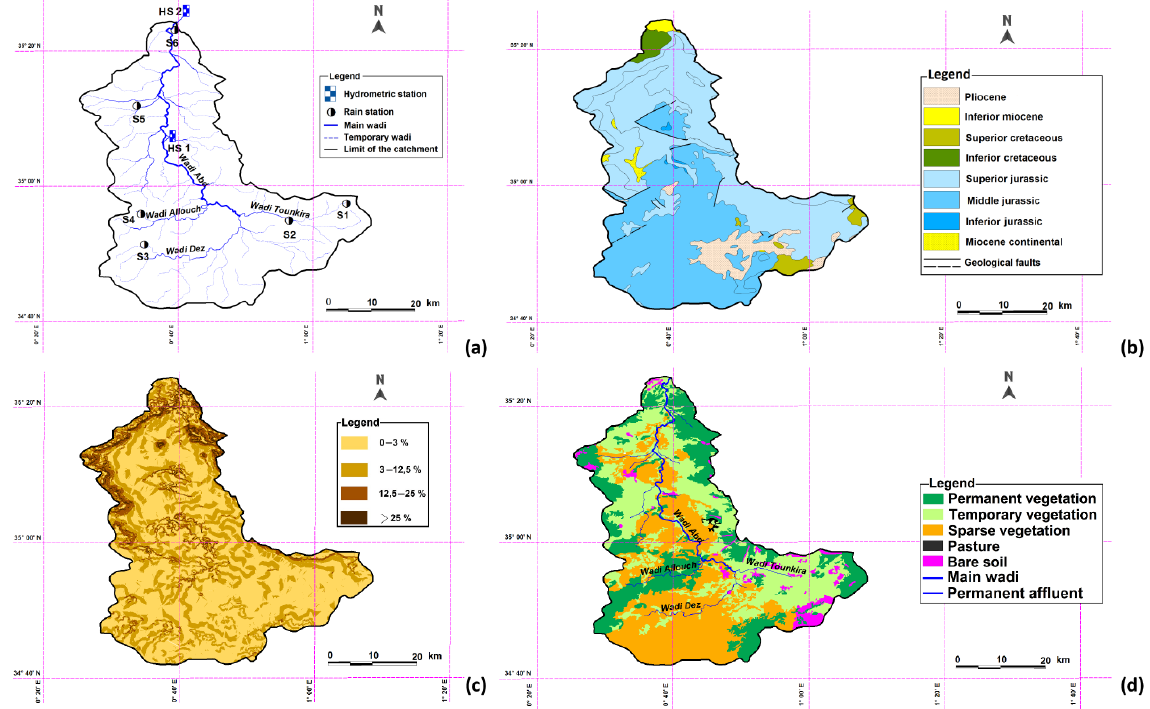
Figure 2. The Wadi Abd catchment area. (a) displays rain and hydrometric stations including HS1 at Takhmaret and HS2 at Ain Hamara, (b) geology, (c) slopes from the digital elevation model of north Algeria, (d) vegetation cover from Landsat ETM + data of